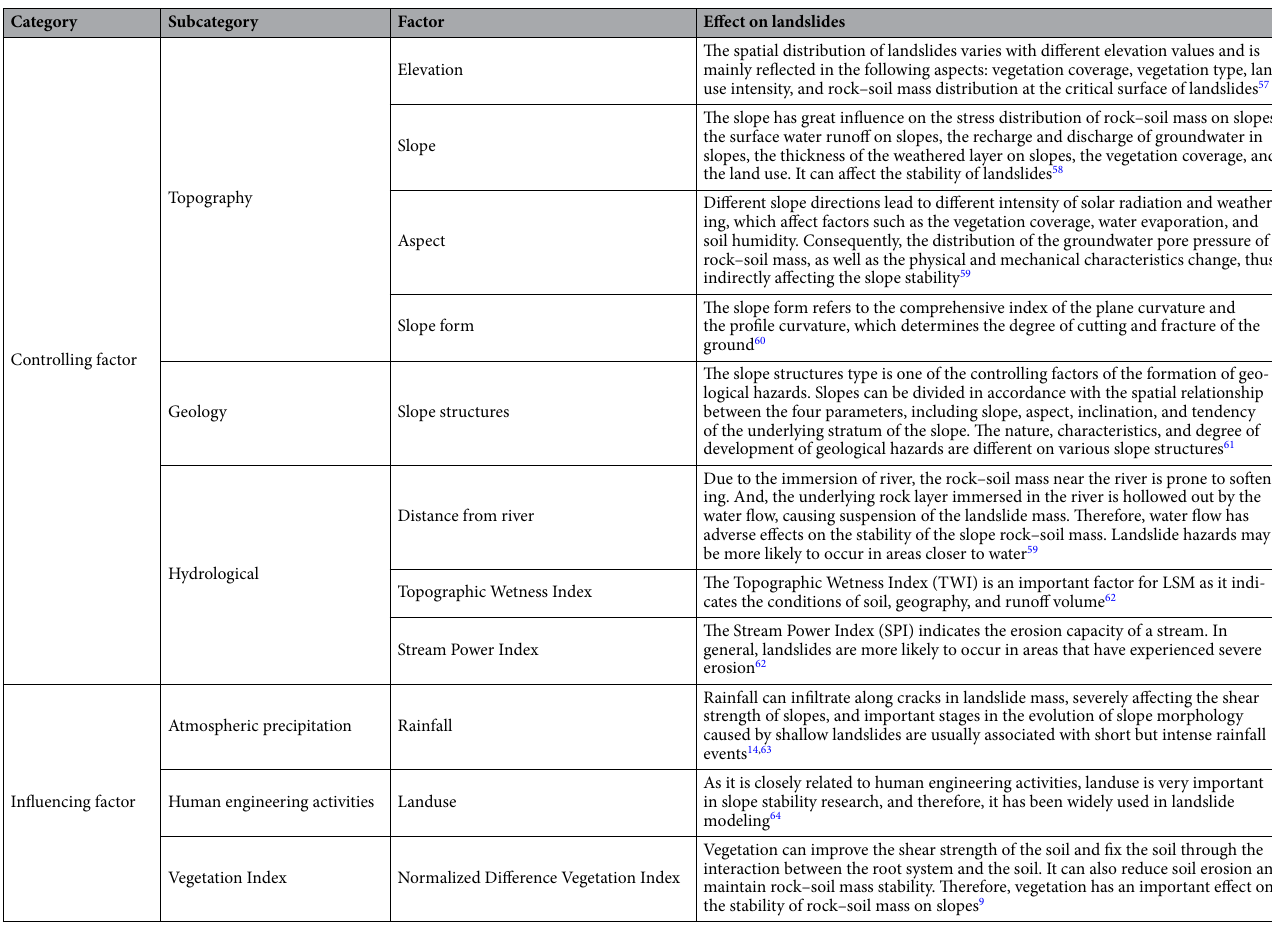
Table 3. Basic factors and effect on